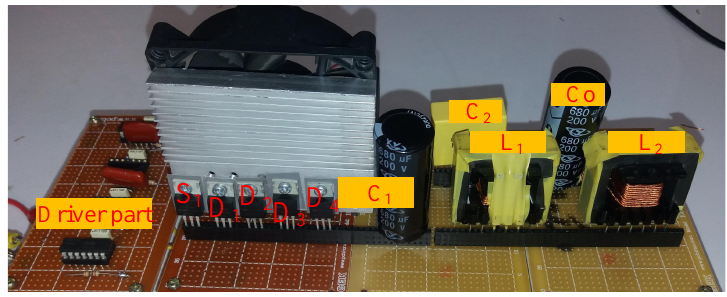
Figure 13. The prototype.